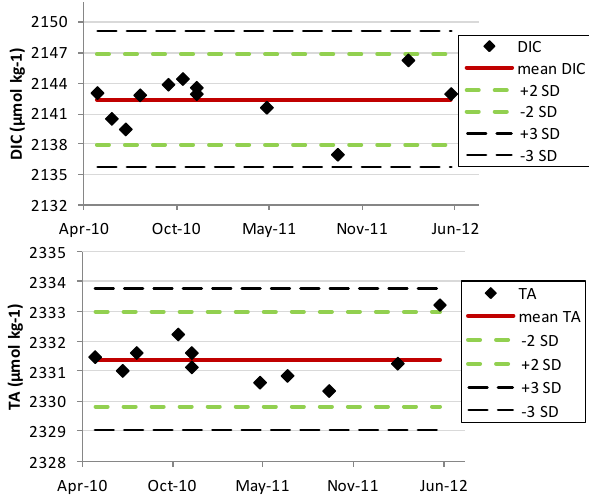
Figure 3. Average monthly (from at least 2 sample bottles) DIC and TA concentrations over 2yr of storage. The mean and standard deviations for DIC were based on the first year of storage when con- centrations were within ± 3 µ molkg − 1 around the mean, while both years of storage results were used for TA as they were all within ± 2 µ molkg − 1 of the